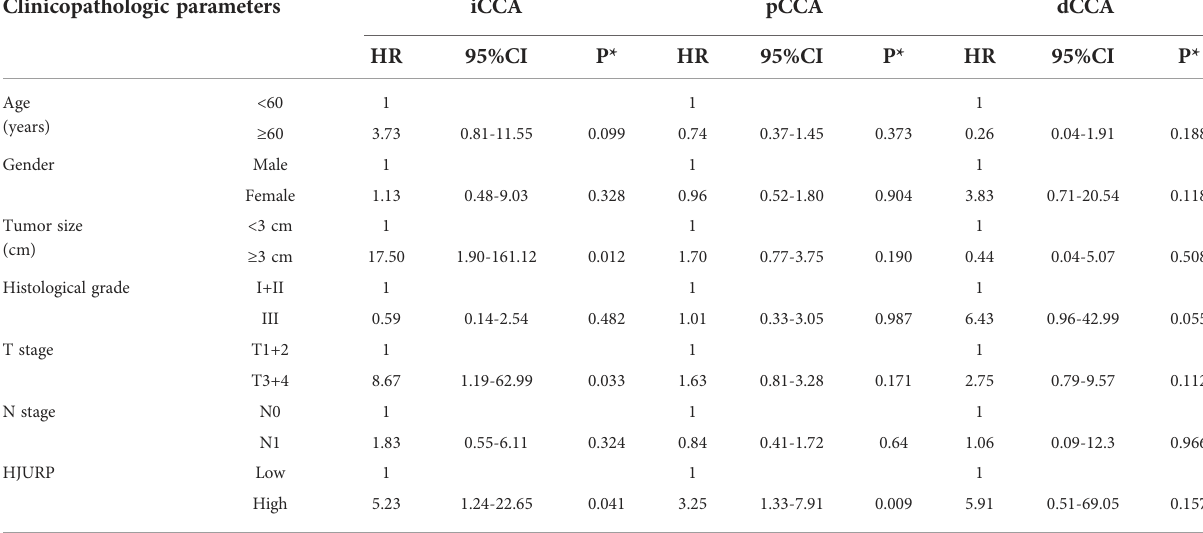
TABLE 4 The independent prognostic factors of